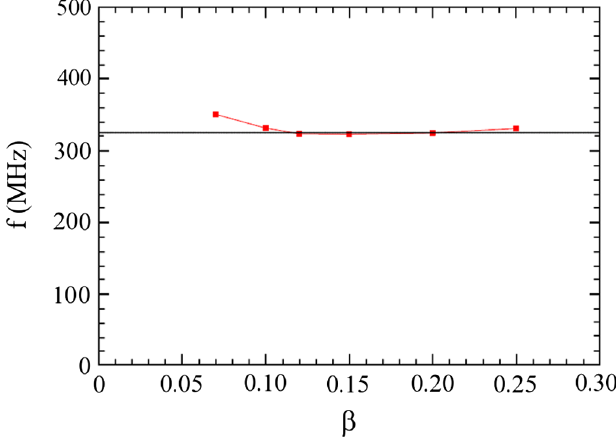
FIG. 14. Analytically calculated rf frequency as a function of (cid:2) in comparison to the simulated cavities tuned at 325 MHz.